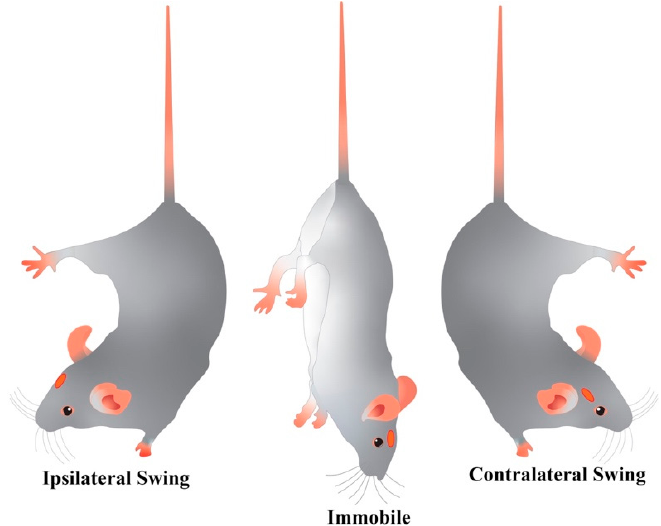
Figure 6. Drawing representing the swinging behavior (ipsilateral or contralateral deviation from animal vertical axis) evaluated with the tail suspension swing test (TSST) in 6-OHDA rats with a lesion on the right SNc (red dot).